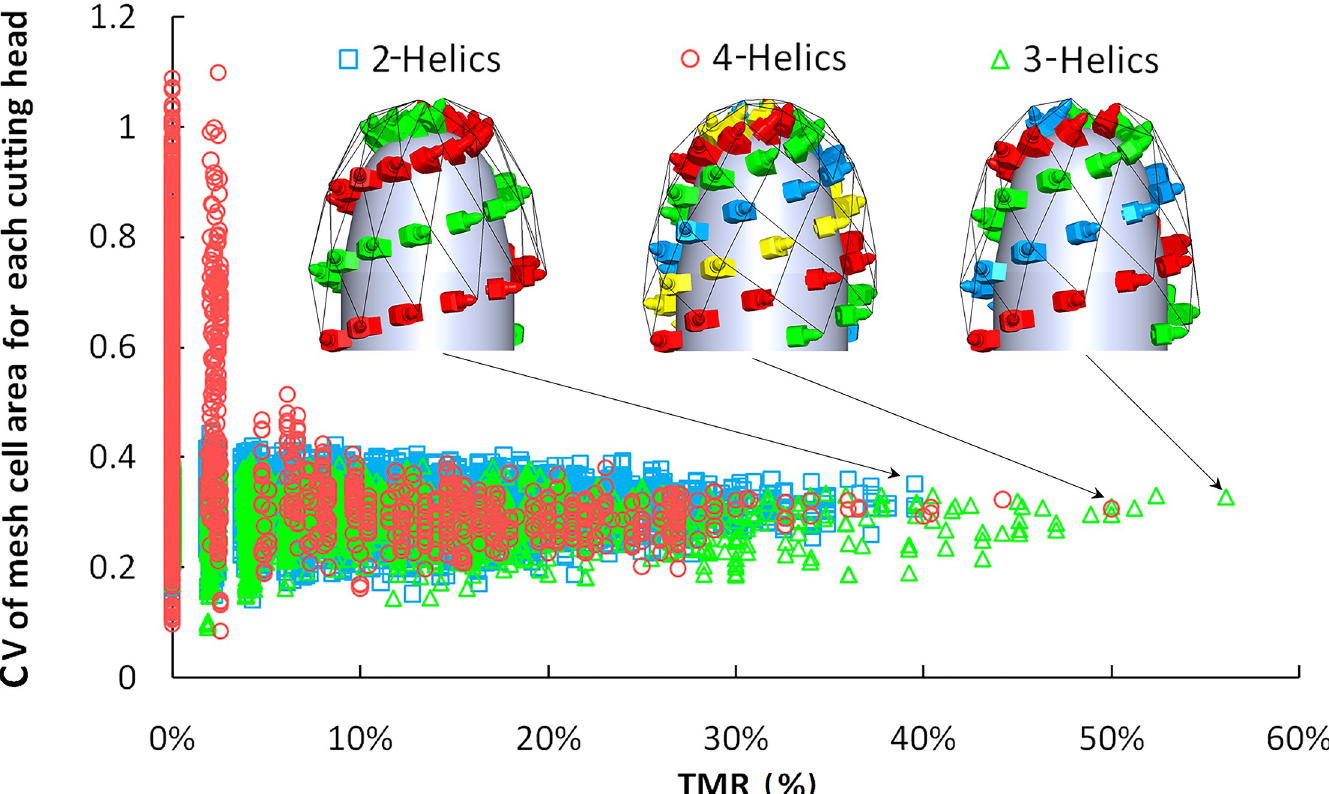
Fig 8. The relationship between CV of mesh cell area and